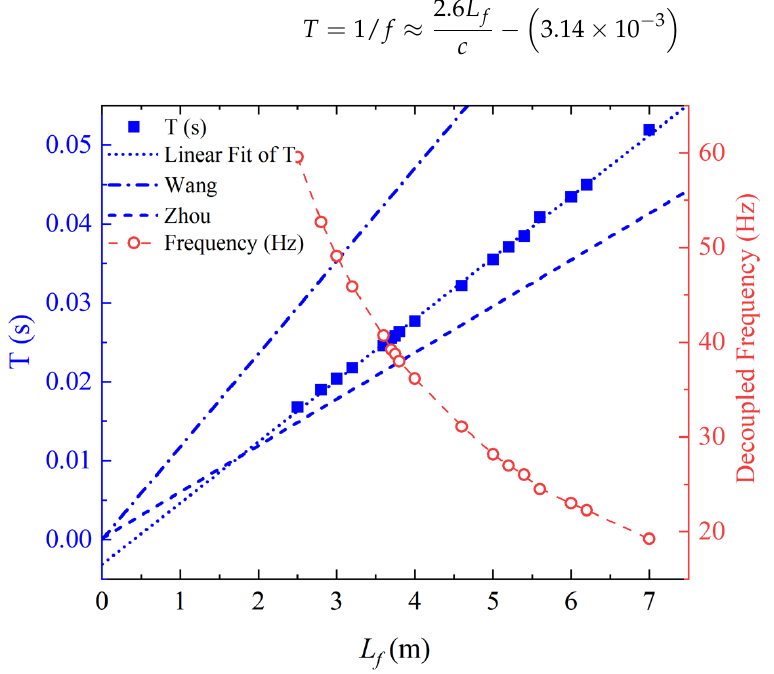
Figure 8. Changes of decoupled frequency and period T with 𝐿 (cid:3033) [38,39].